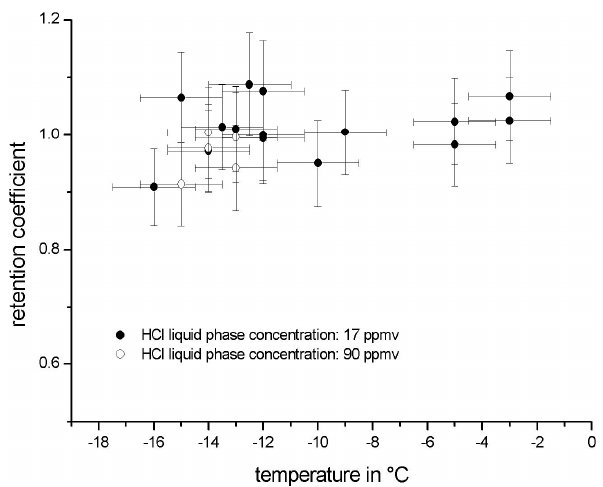
Fig. 3. Retention coefficient of HCl as a function of ambient air temperature, determined with captively floating ice particles rimed with solution droplets of two concentrations (black circles: 17ppmv, open circles: 90ppmv).